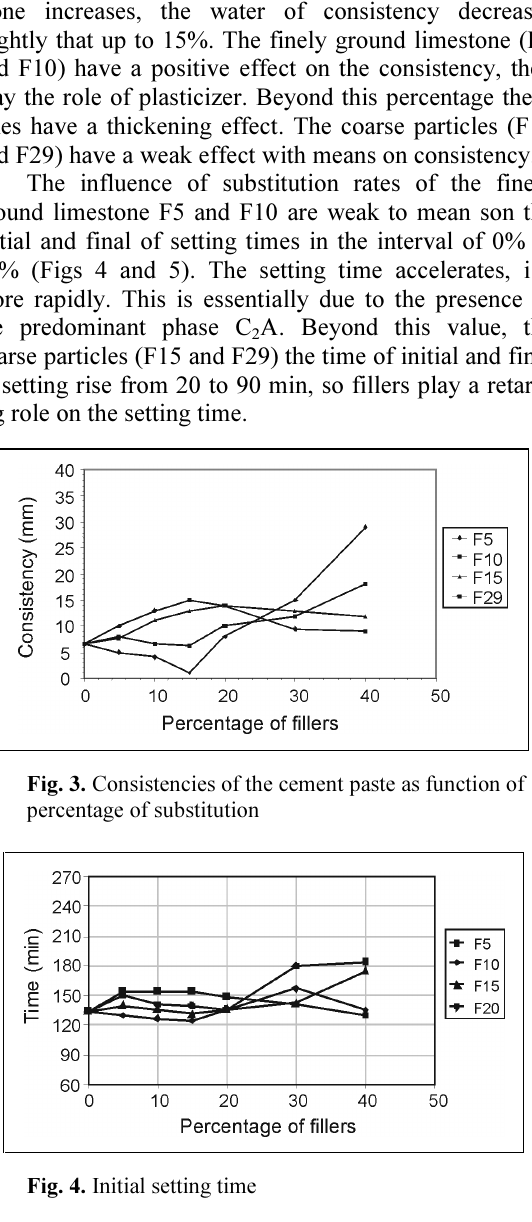
Fig. 4. Initial setting